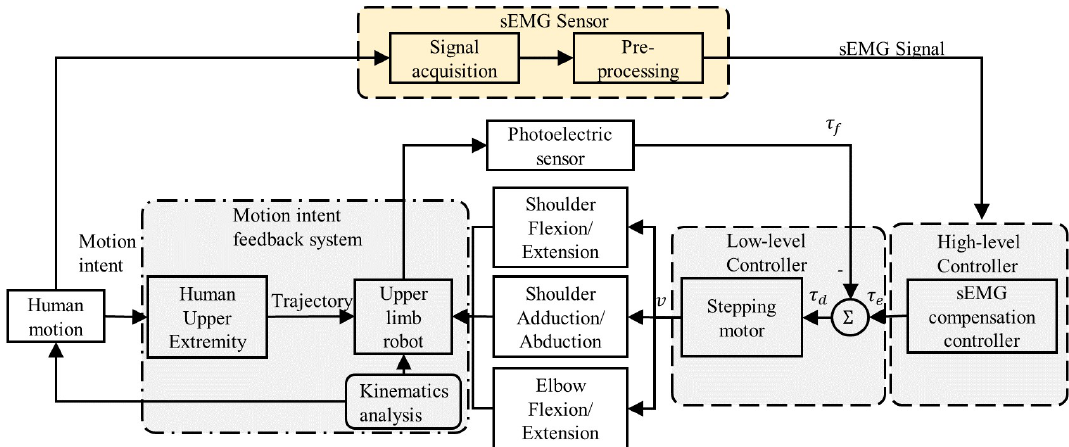
Figure 3. Control